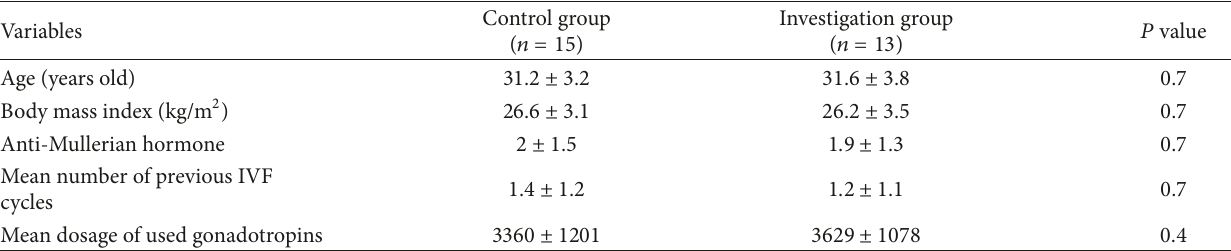
Table 1: Characteristics of participants in both